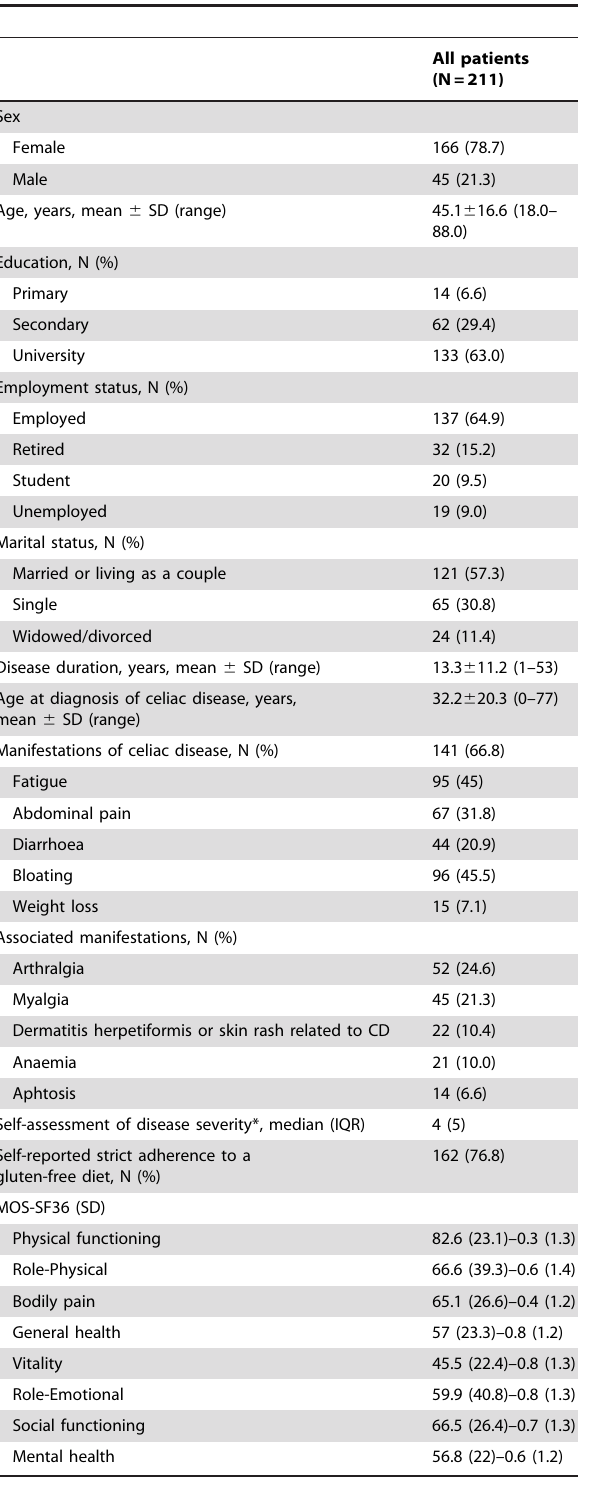
*: disease severity was assessed on a visual analogue scale (0–10) with 10 indicating the most severe disease; CD: celiac disease; IQR: interquartile range. The MOS-SF36 scores are presented both as raw score and as age- and sex- adjusted standardised scores using the French general population reference values for age (10-year interval groups) and gender, and expressed as standard deviations